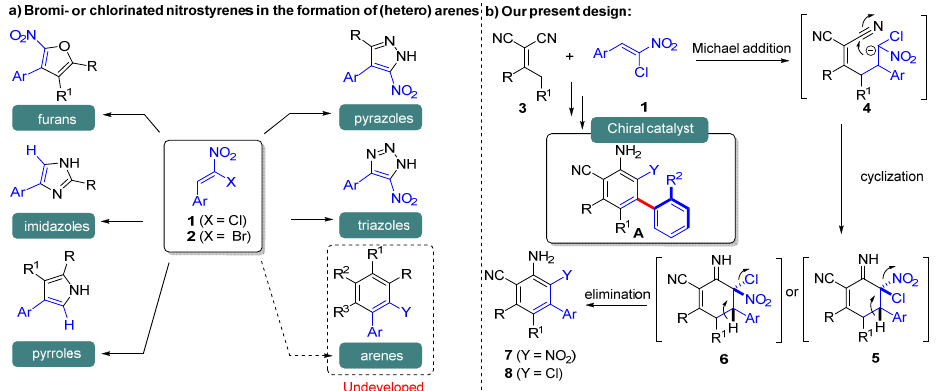
Figure 1. Recent development of bromi- or chlorinated nitrostyrenes in (hetero)arene synthesis.